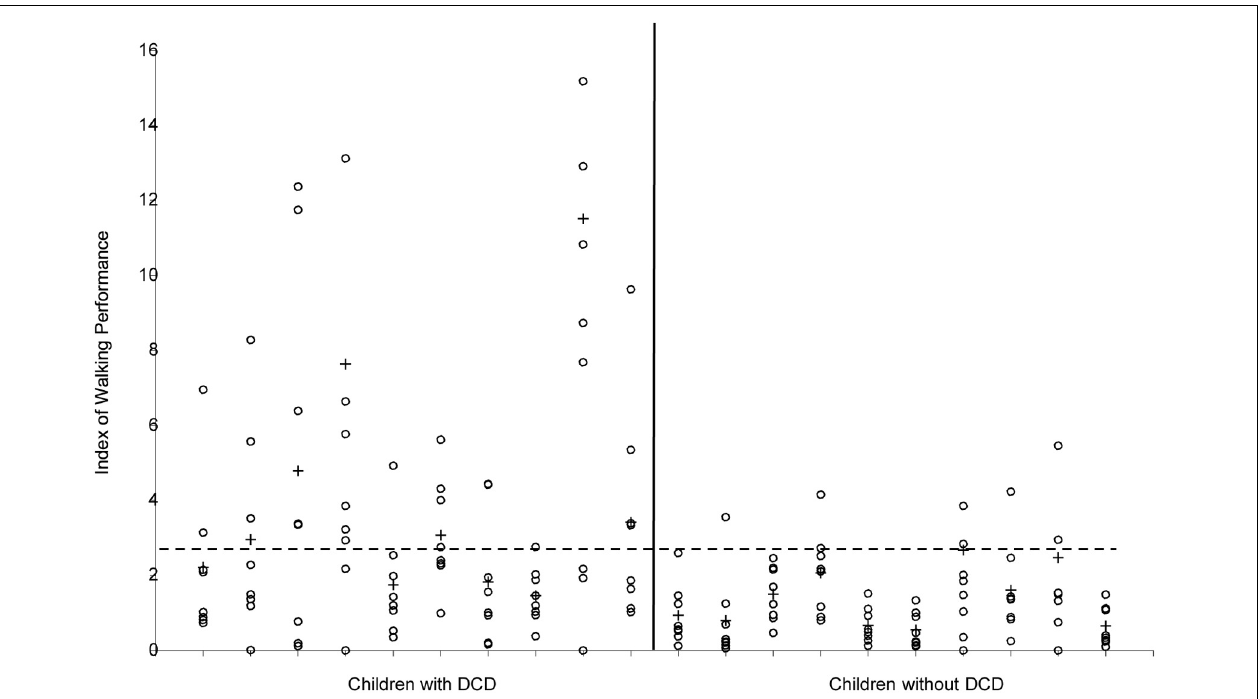
FIGURE 6 | Index of Walking Performance of the 10 children with and the 10 children without DCD. Values of the separate strides are indicated with ◦ , means per child are indicated with + . The horizontal broken line indicates the cut-off value (2.69) according to Woodruff et al.